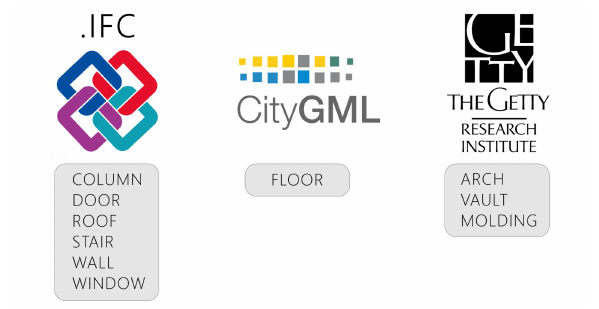
Figure 2 . The standards used to determine the classes of architectural elements to be considered.